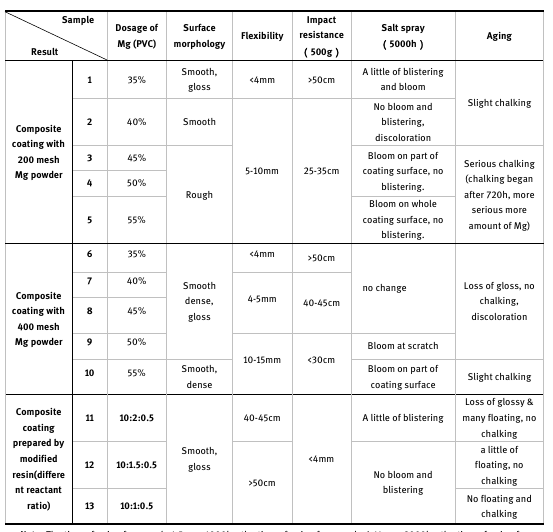
loosely on the surface of coatings and cannot provide ad- ditional shielded protection. Table 1 (sample 6-10) was the experimental result of the samples prepared by 400 mesh Mg